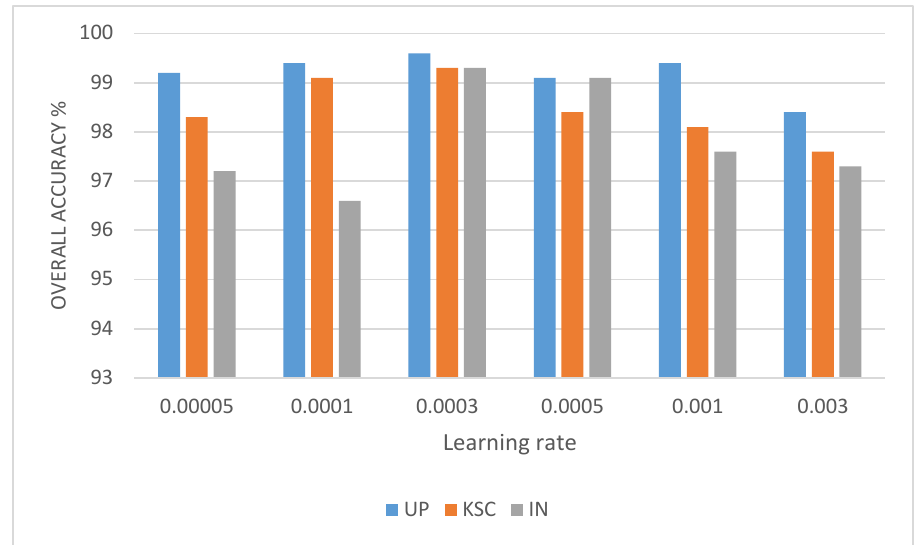
Figure 9. Overall accuracy (OA, %) of the proposed network with different learning rates in Indian Pines (IN), Pavia University (UP), and KSC dataset.